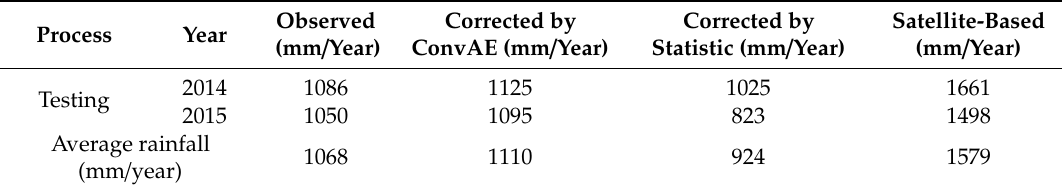
Table 2. Total annual precipitation over the Mekong basin during the testing period. ConvAE: convolutional